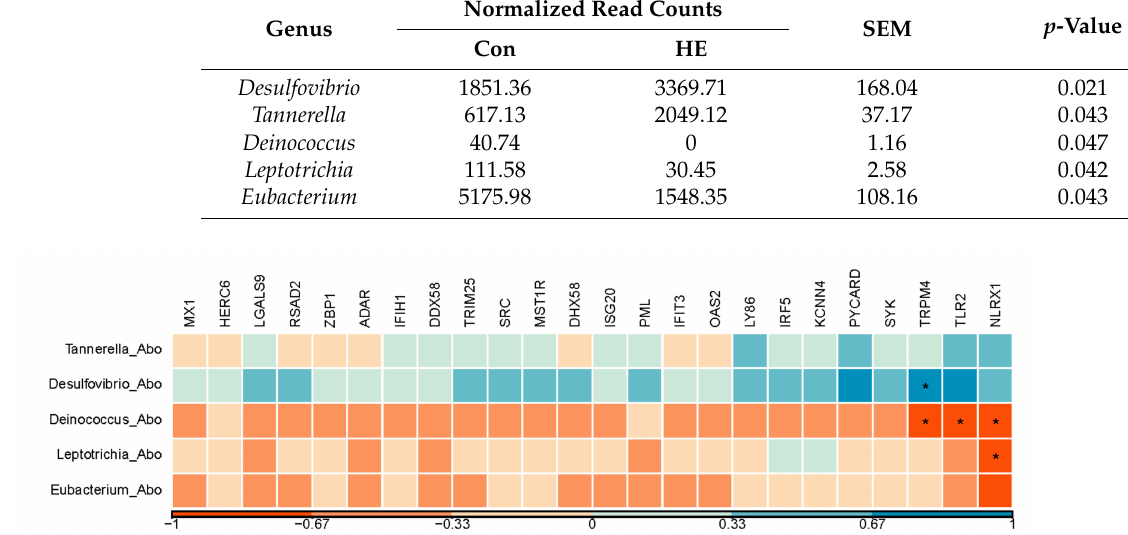
Figure 4. A Pearson correlation matrix between significantly changed active bacteria and the genes enriched in immune response. The scale of the colors is denoted as follows: the more positive the correlation (closer to 1), the darker the shade of blue; the more negative the correlation (closer to − 1), the darker the shade of red. *: p < 0.05; Abo: abomasum